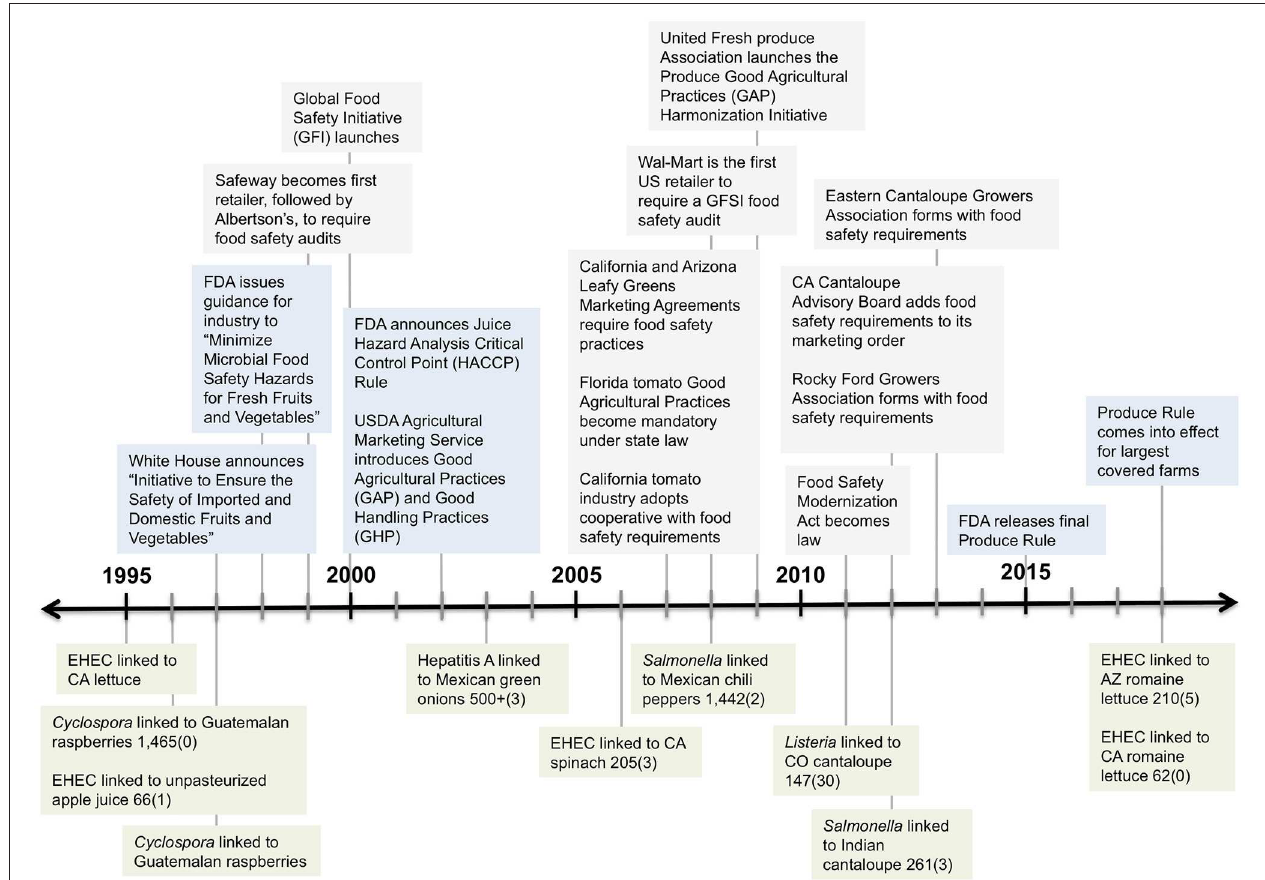
FIGURE 2 | Timeline of selected outbreaks of foodborne illness and food safety policy responses in the US, 1995–2018. Green boxes indicate selected major outbreaks with the number of illnesses, and deaths in parentheses, for the US and Canada combined (for outbreaks with available data). Blue boxes indicate food safety actions by government. Gray boxes indicate food safety responses by industry. Adapted from Table 1 in Minor et al. (2019) with additional data from the California Food Emergency Response Team (2007) and US Centers for Disease Control (CDC)